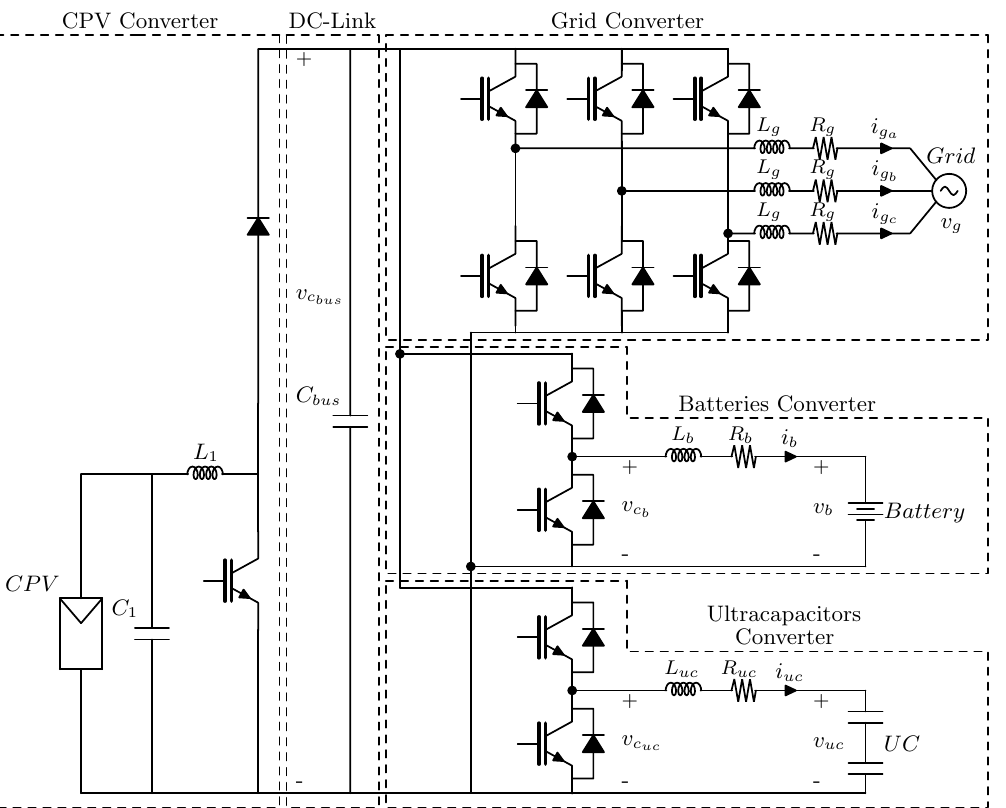
Figure 2. Detailed scheme of the hybrid energy storage system (HESS) for a concentration photovoltaic (CPV)